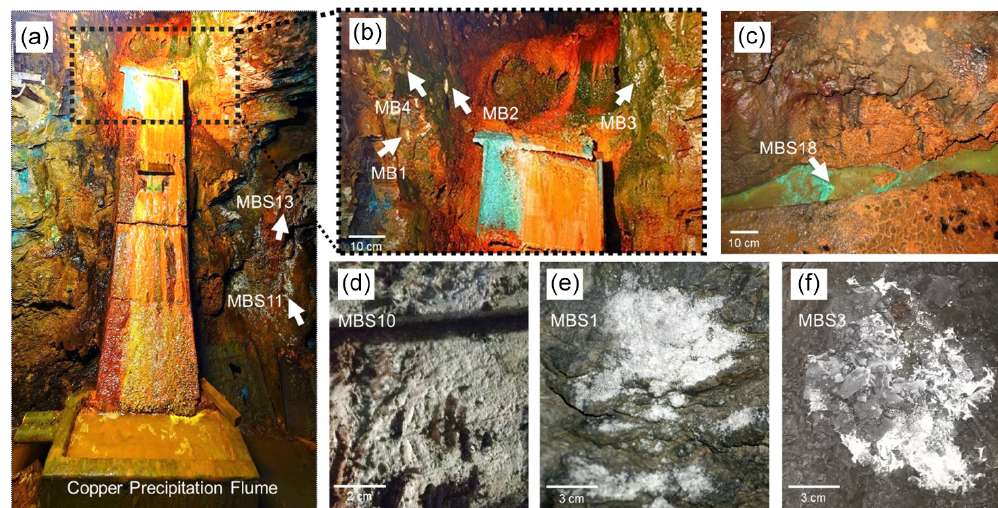
Figure 2. Kilianstollen biological samples. Samples were taken from sites in the vicinity of a copper precipitation flume (a, b) that is drained actively with the leachate water, from a wooden plank (d) located just right to the copper flume, directly from the outflow stream (c) near the opening, and from rocky mine walls (e, f) exposed to the karstwater and pit water stream at the rear end crosscut of the